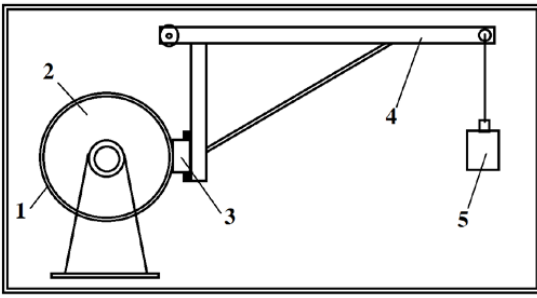
Figure 2. Schematic of abrasion test apparatus. 1-sand belt, 2-Steel disc, 3-Specimen, 4-Ever arm, 5-Weight.